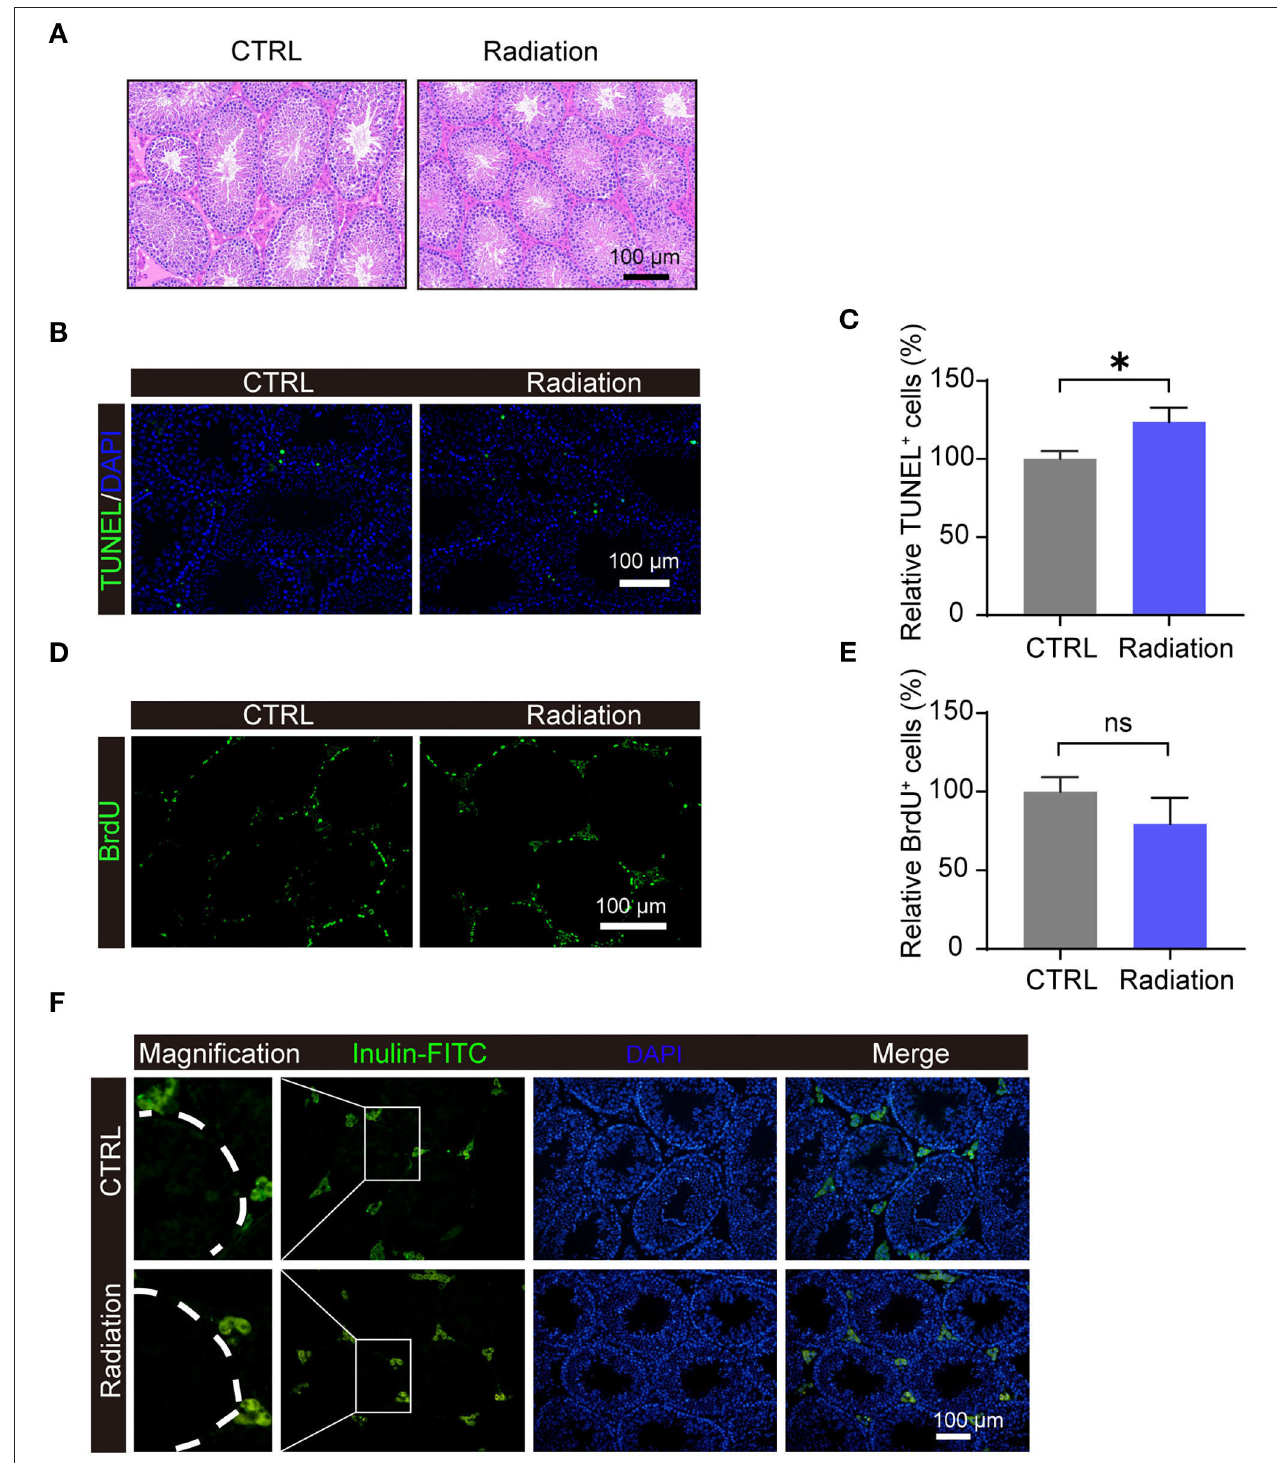
FIGURE 2 | Impact of RF-EMR (electromagnetic radiation) exposure on murine testis. (A) H&E staining of the testes from CTRL or Radiation mice. (B,C) Detection of apoptosis in testes of CTRL and Radiation mice using TUNEL staining. (D,E) Detection of BrdU incorporation post intraperitoneal injection in the testis of CTRL and Radiation mice. (F) In the testis of both CTRL and Radiation group, Inulin-FITC was located near the base of the seminiferous tubule. (A–F) CTRL, mice in sham group; Radiation, mice in RF-EMR exposure group. * P < 0.5; ns, not significant. n = 6 for both groups. The Student’s t -test was performed to compare groups. Scale bar = 100 µ